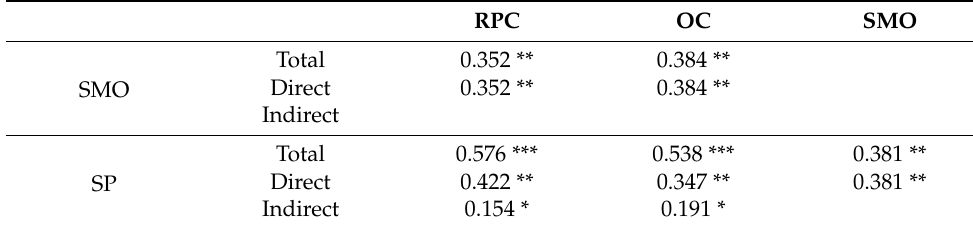
Table 11. Total, direct, and indirect effects among safety constructs in Mainland China.